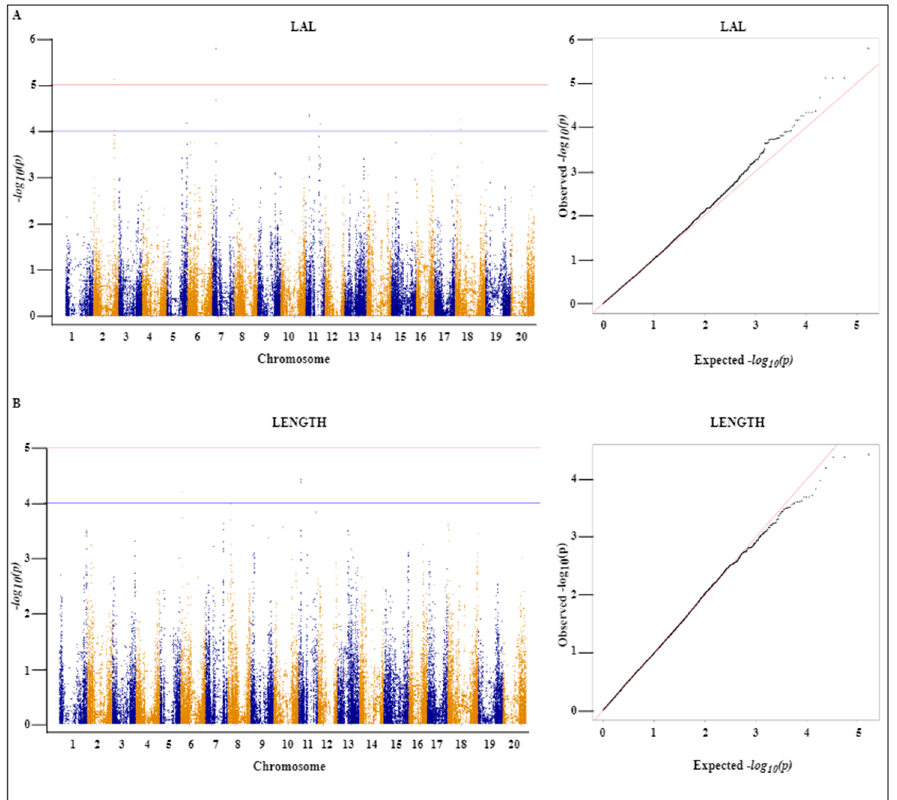
Figure 3. Manhattan and quantile-quantile (QQ) plots of the 357 soybean landraces using the MLM model. ( A ) Link average length (LAL) and ( B ) total root length (LENGTH). The X-axis represents the chromosome number and the Y-axis represents the − log10 ( p ) value. The threshold of 4.0 (Bonferroni correction) was adopted with the blue line in the Manhattan plots. The Manhattan and QQ plots are based on analyses of the associations between 84,210 chromosomal SNPs and DIAM and LAD traits.